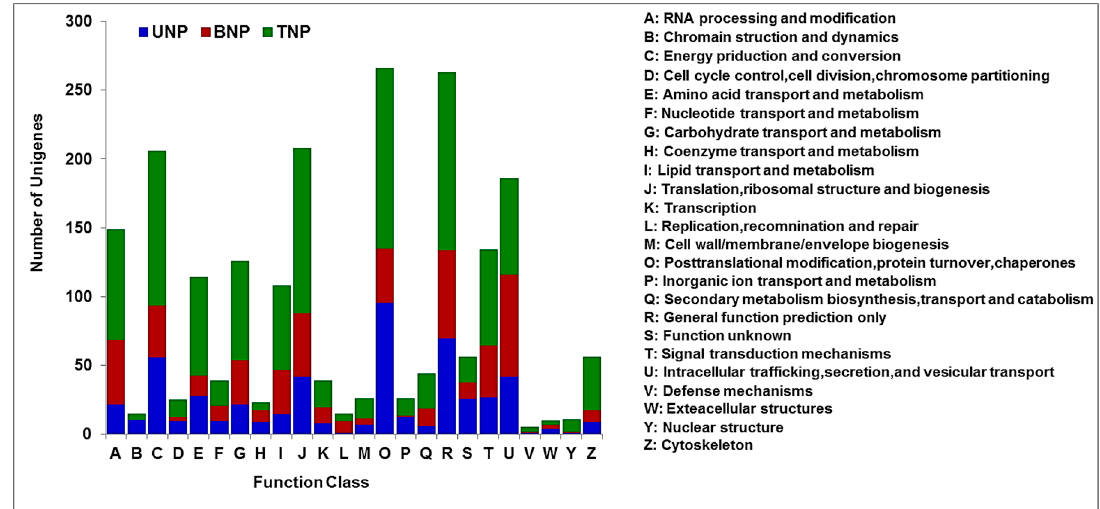
Figure 5. Eukaryotic Orthologous Groups of proteins (KOG) classifications for differentially abundant proteins (DAPs) in KTM3315A and TM3315B from the uninucleate stage (UNP) to the trinucleate stage (TNP). Capital letters on the x -axis represent the KOG categories listed to the right of the histogram. The y -axis shows the number of DAPs.